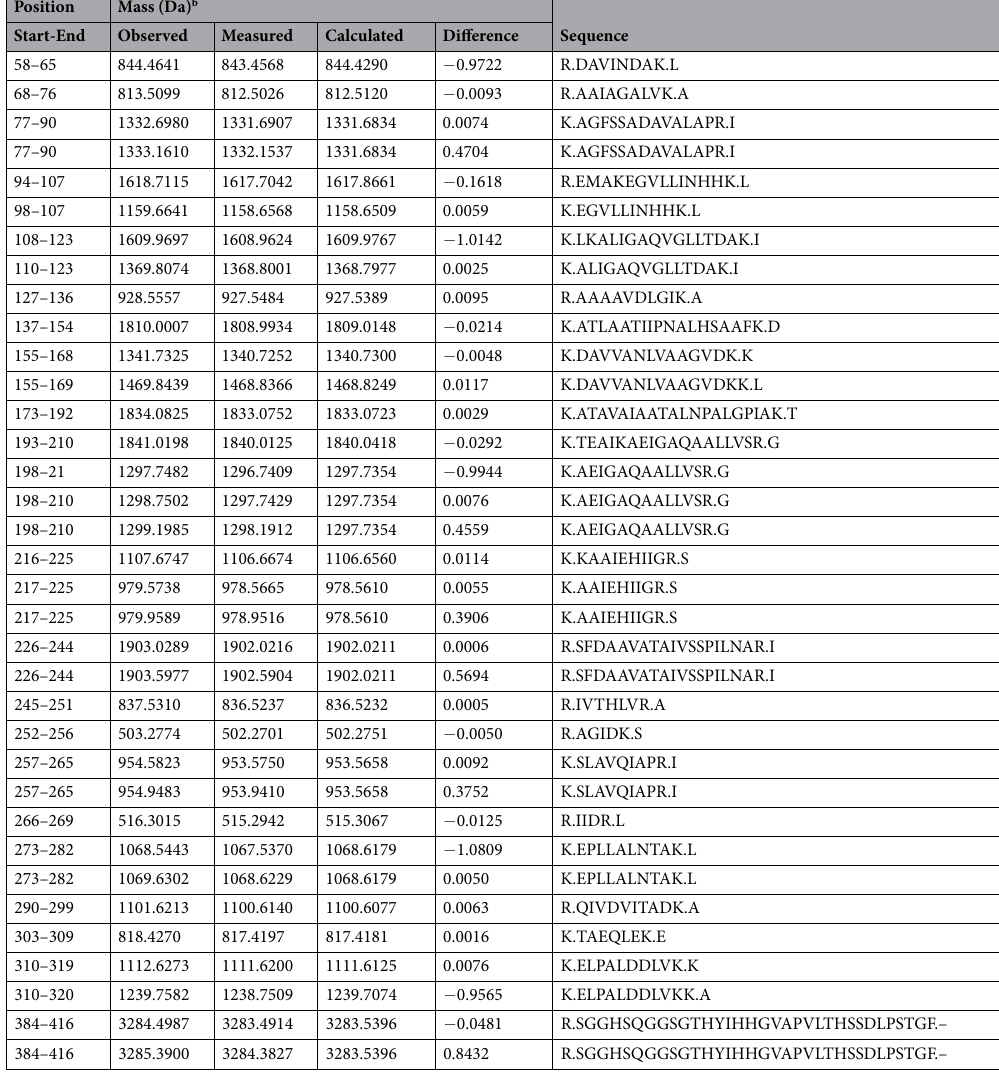
Table 1. Measured and calculated molecular masses for tryptic peptides. a These peptides, which identified the 58 kDa protein, correspond to 267 of the 416 residues, corresponding to 64% sequence coverage (See also Fig. 2). b Mono-isotopic